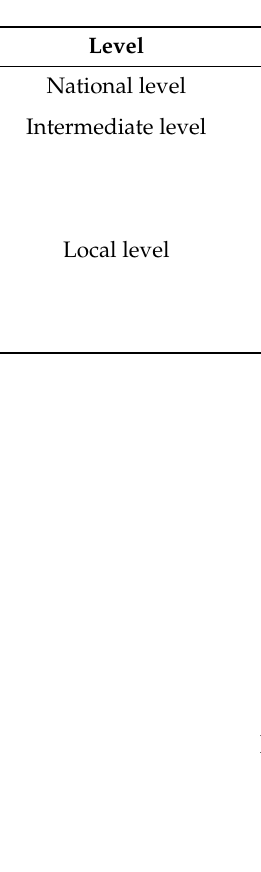
Table 1. The infrastructure system of occupational health